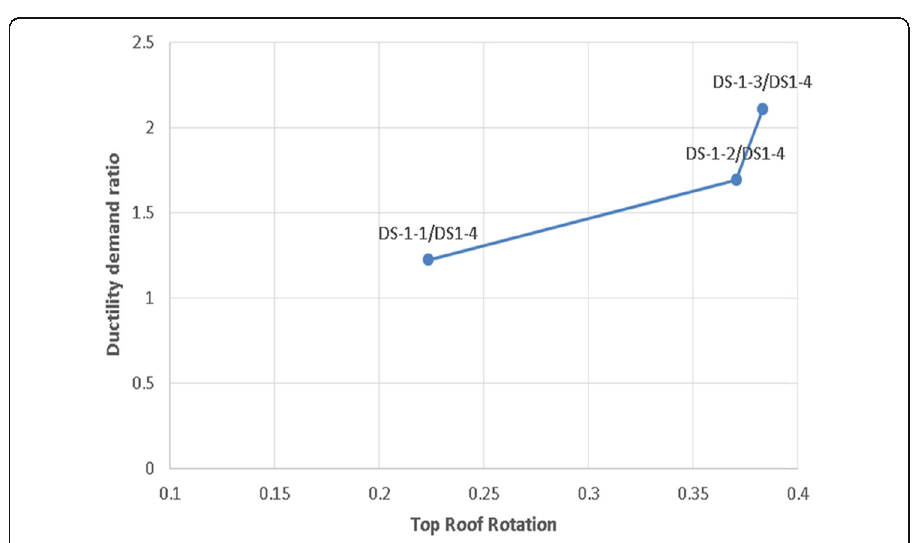
Fig. 26 Comparison of rotation — ductility demand the ratio for stiff elements located 16 m from center of mass for (DS-1-1, DS-1-2, and